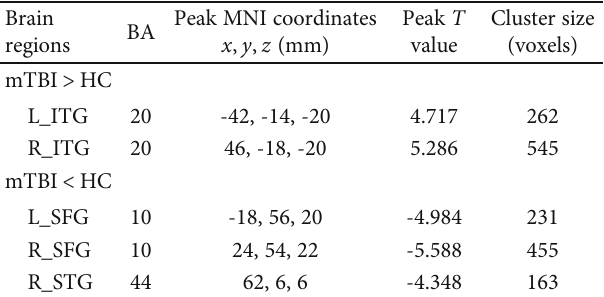
Figure 2: The CBF di ff erences between the mTBI patients and the HC subjects after GMV correction. Compared with HC, the acute mTBI patients showed increased CBF in the bilateral inferior temporal gyrus (ITG) as well as decreased CBF in the bilateral superior frontal gyrus (SFG) and right superior temporal gyrus Table 3: Brain regions with signi fi cant group di ff erences in normalized CBF with GMV correction.